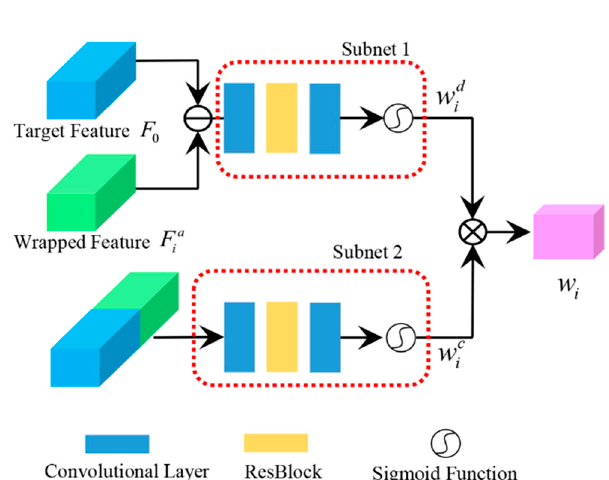
Figure 4. The architecture of the dual-weighting (DW) module.